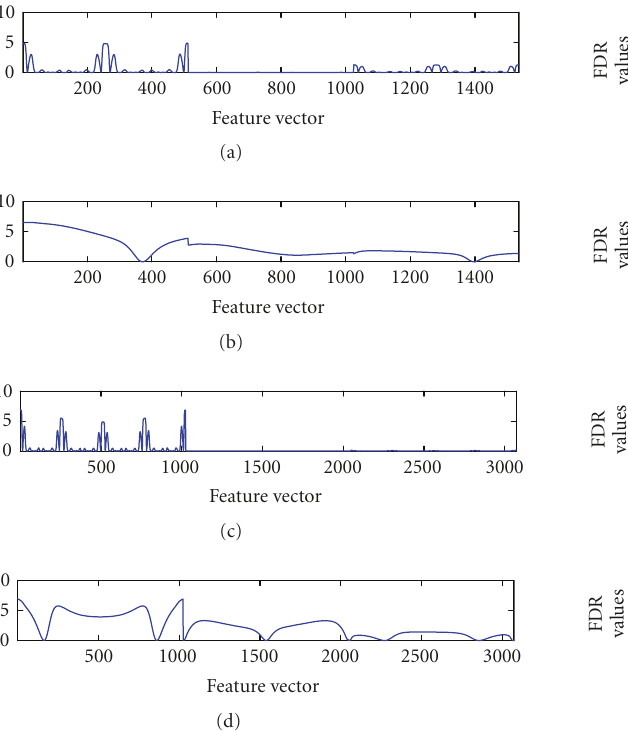
, (c) (cid:21) c f , and (d) (cid:21) c f Figure 12: FDR values related to (a) (cid:9) c u , (b) (cid:9) c u or or feature vectors when the disturbance is impulsive transient.